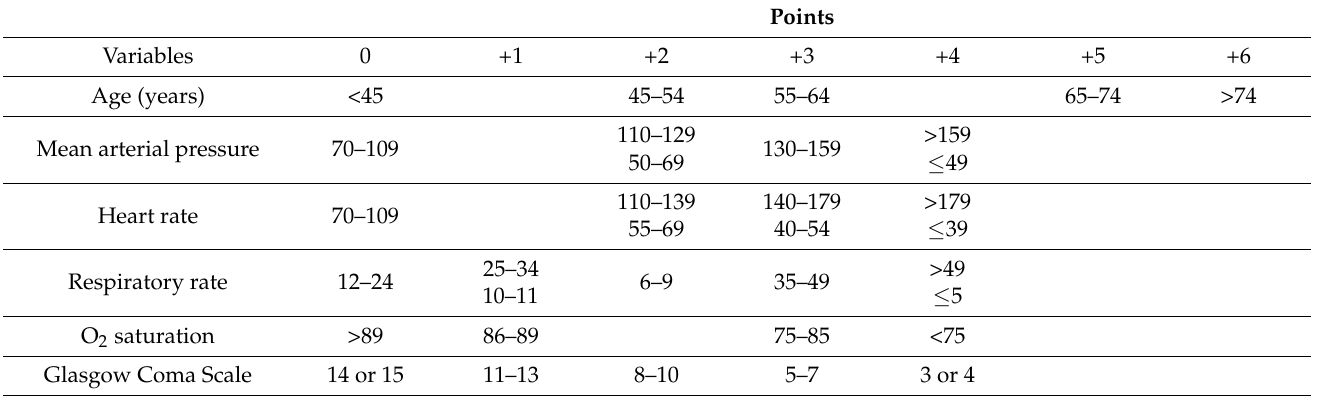
Table 7. Variables and pointsof the Rapid Emergency Medicine Score (REMS).